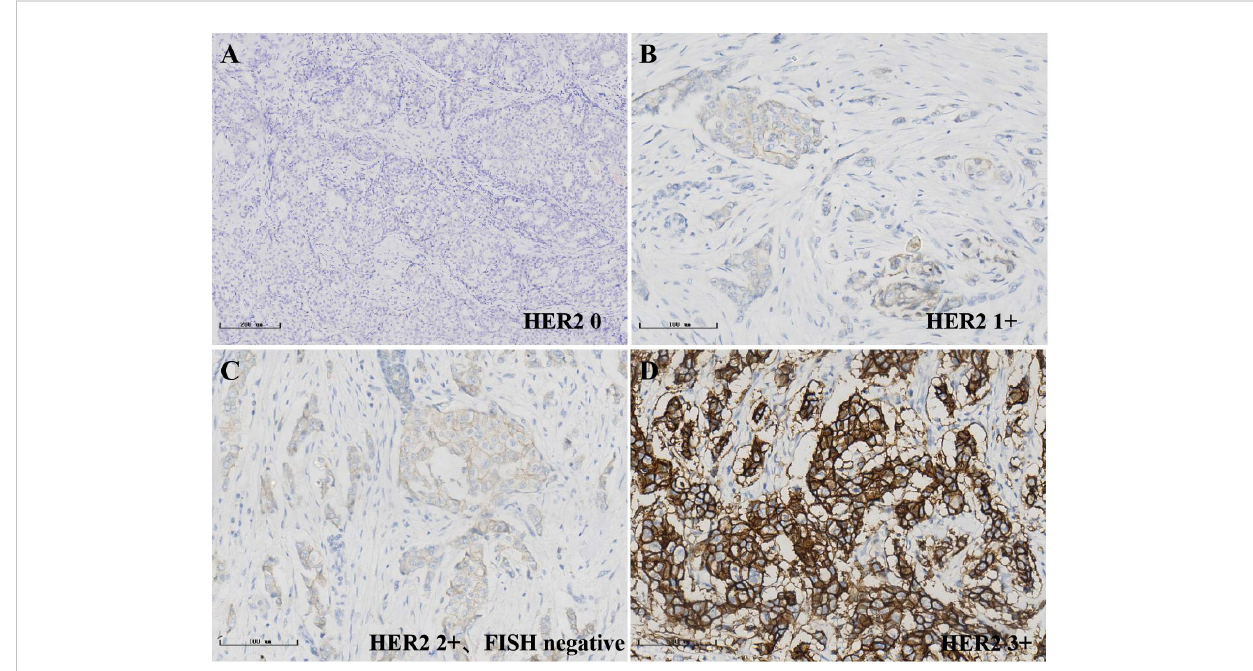
FIGURE 2 Immunohistochemical detection of HER2 status in breast cancer, streptavidin-perosidase (SP); (A) 0; (B) 1+; (C) 2+; (D) 3+.